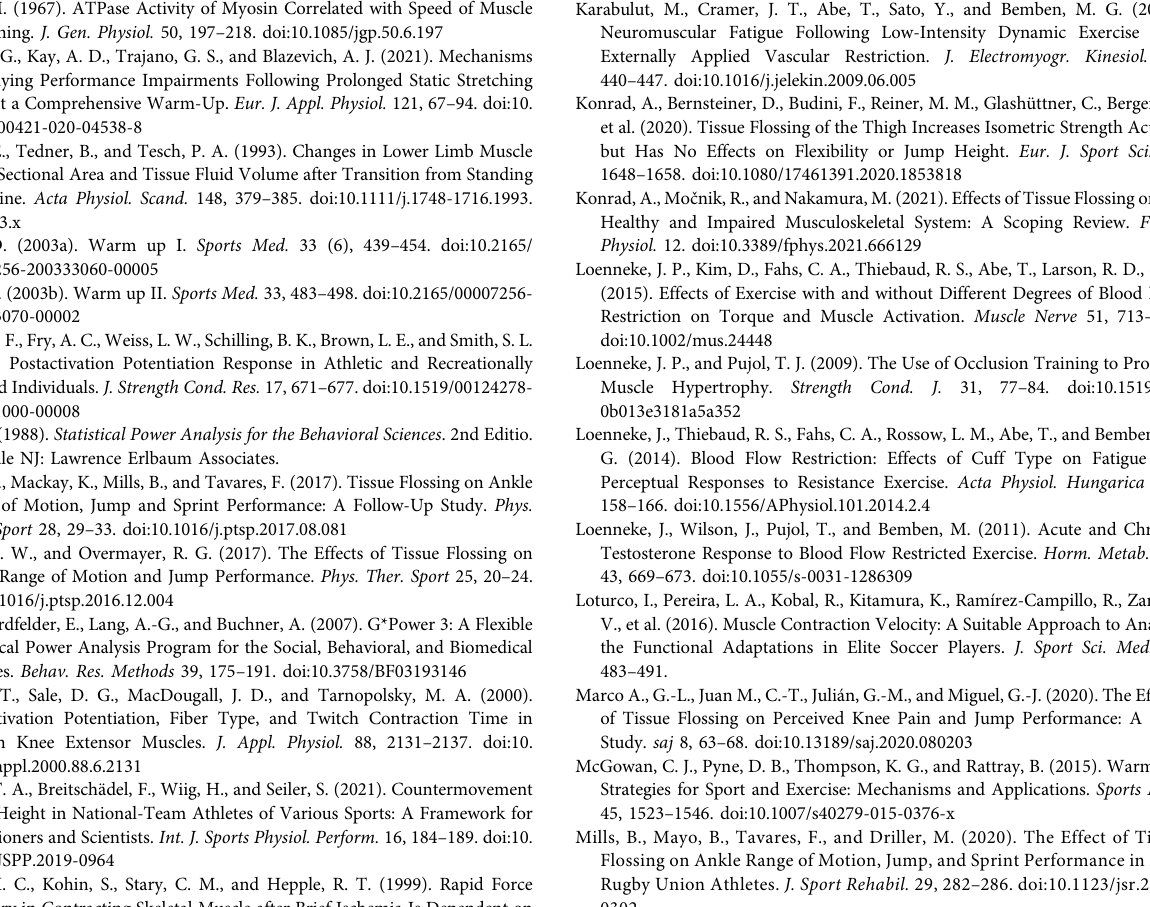
Jump Height in National-Team Athletes of Various Sports: A Framework for Practitioners and Scientists. Int. J. Sports Physiol. Perform. 16, 184 – 189. doi:10. 1123/IJSPP.2019-0964 Hogan, M. C., Kohin, S., Stary, C. M., and Hepple, R. T. (1999). Rapid